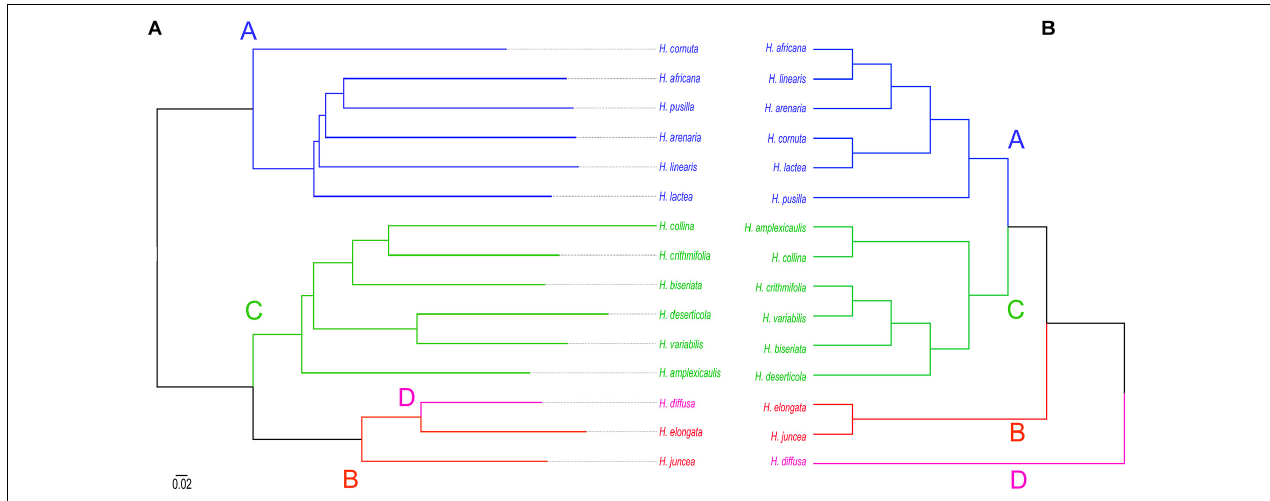
FIGURE 5 | Phylogenetic relationships between 15 Heliophila species based on repeat sequence similarities (A) and ITS sequences (B) . Scale bar indicates mean branch length across all individual trees to infer the consensus tree.